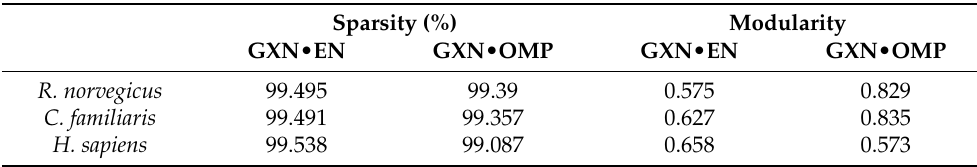
Table 3. RNA-seq Eukaryotic datasets sparsity and